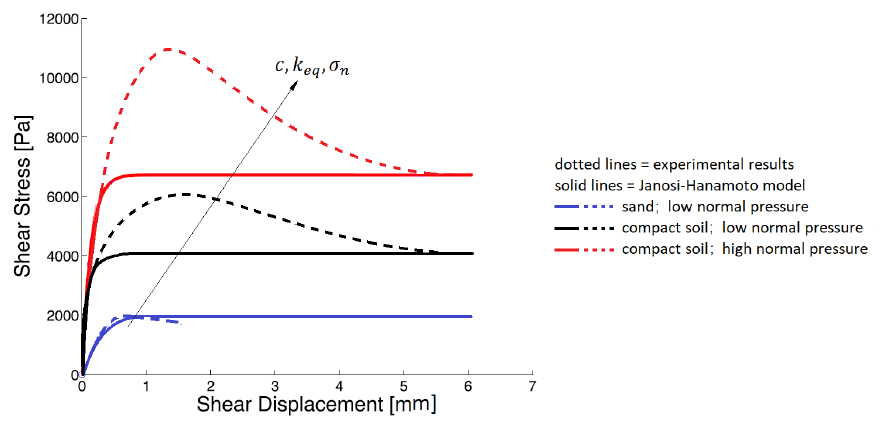
Figure 1. Janosi-Hanamoto model and experimental results, for different types of soil. Experimental data usually exhibit a peak in the traction capabilities for certain values of the shear